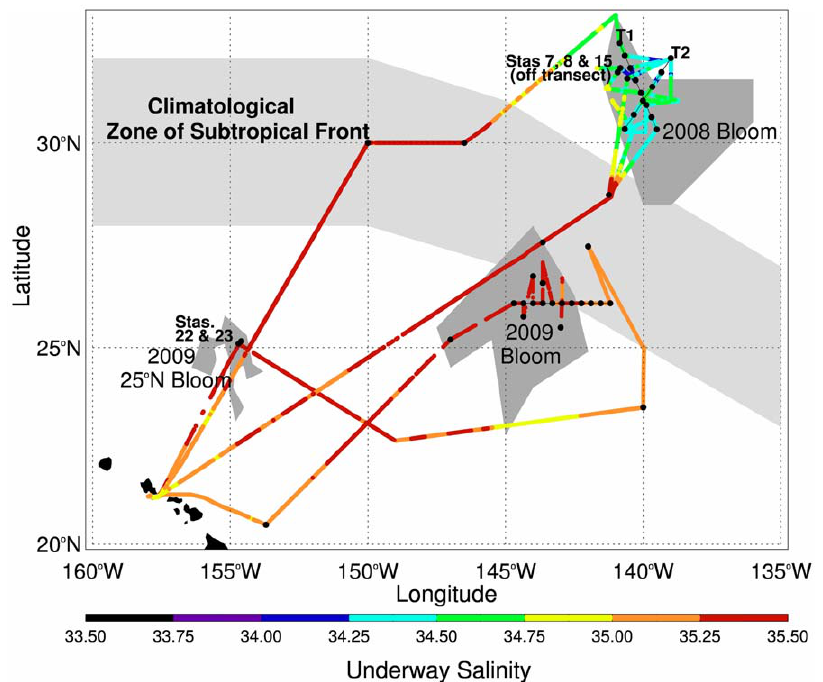
Figure 1. Cruise tracks for 2008 and 2009. Surface salinity data from the ship’s underway sampling system is color coded along the shiptrack. The climatological mean position of the subtropical front [48,49] is shaded in light grey. Bloom areas were derived from ocean color data (see text for details).